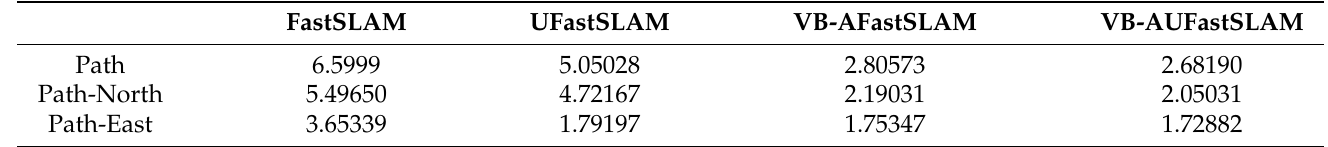
Table 8. The respective RMSE for each algorithm